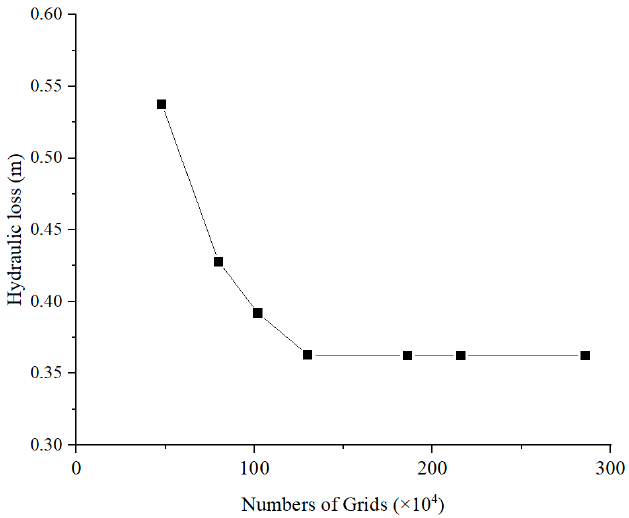
Figure 4. Hydraulic loss trend chart.